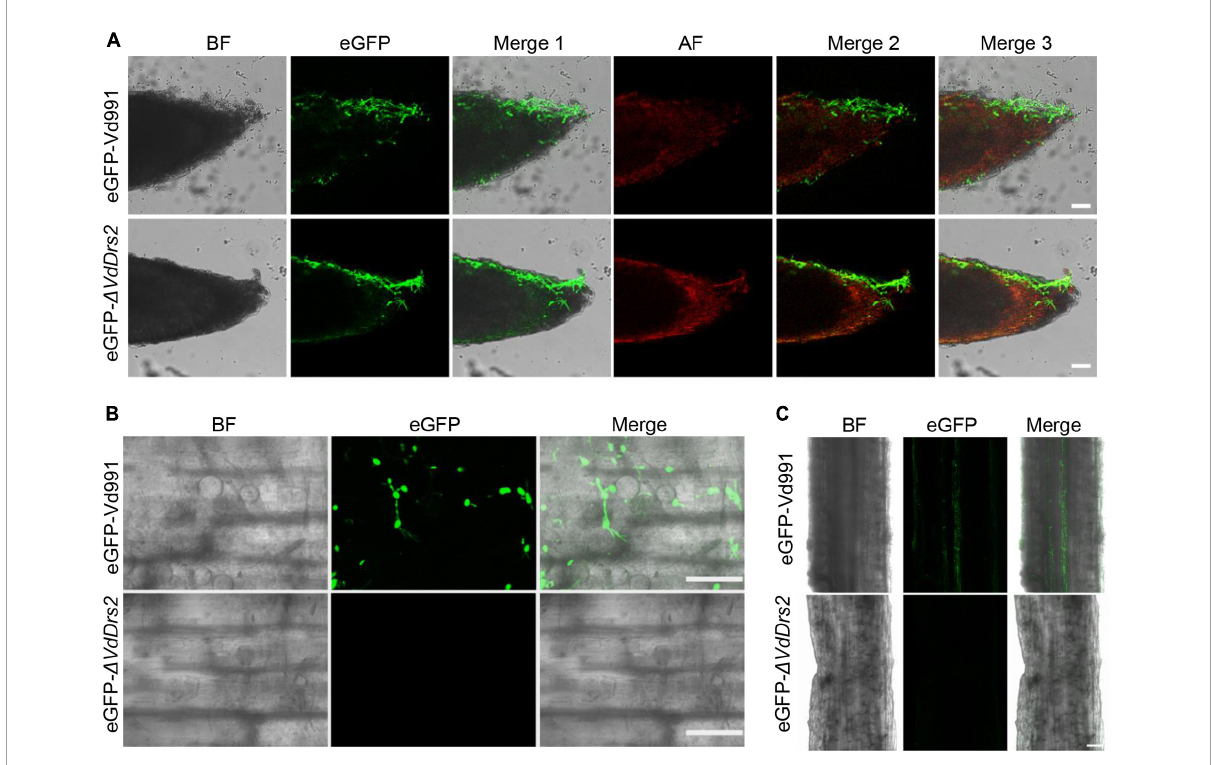
FIGURE3 Knockout of VdDrs2 delays the infection of V. dahliae to cotton. (A) Confocal microscopy images of eGFP-labeled hyphae on the root surface. Cotton roots were infected with eGFP -Vd991 and eGFP- (cid:49) VdDrs2 by pouring 50 mL spore suspension (1 × 10 7 spores/ml) to each growth pot. Root tips were observed with confocal microscope 2 days after inoculation. Scale bars represent 50 µ m. BF, bright field; AF, autofluorescence; Merge 1, the green fluorescence image is merged with bright field image; Merge 2, the green fluorescence image is merged with red fluorescence image; Merge 3, the green fluorescence image is merged with bright field image and red fluorescence image. (B) Confocal microscopy images of eGFP-labeled hyphae in the roots. Cotton roots were infected with eGFP -Vd991 and eGFP- (cid:49) VdDrs2 for 7 days, respectively. Fragments between 0.5 to 1.5 cm away from the root tip were cut out for section and were observed with confocal microscope. Scale bars represent 25 µ m. (C) The penetrating hyphae of eGFP -Vd991 or eGFP- (cid:49) VdDrs2 strains were observed by confocal microscope. Cotton roots were infected with eGFP -Vd991 and eGFP- (cid:49) VdDrs2 for 7 days. Fragments 1.5–2.5 cm away from the root tip was cut into thin slices and were observed with confocal microscope. Scale bar represents 50 µ m.